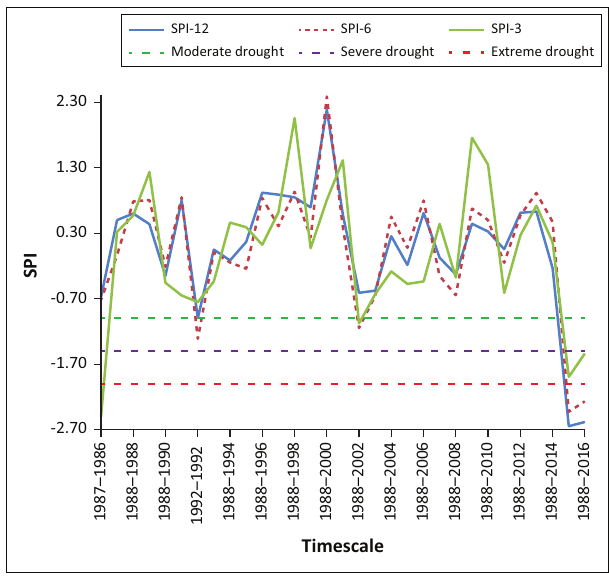
FIGURE 4: Standard Precipitation Index values of Eswatini for three different timescales (3, 6 and 12